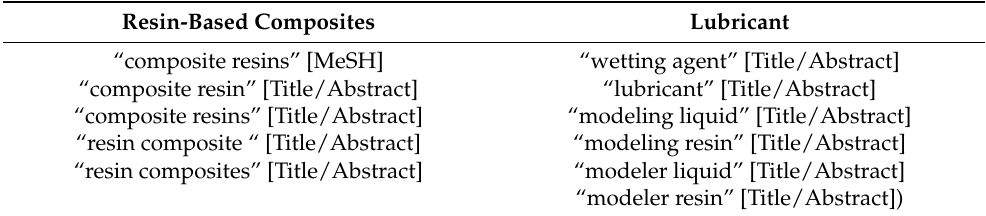
Table 1. Derivative sequence of keywords and MeSH terms used for the search strategy. Resin-Based